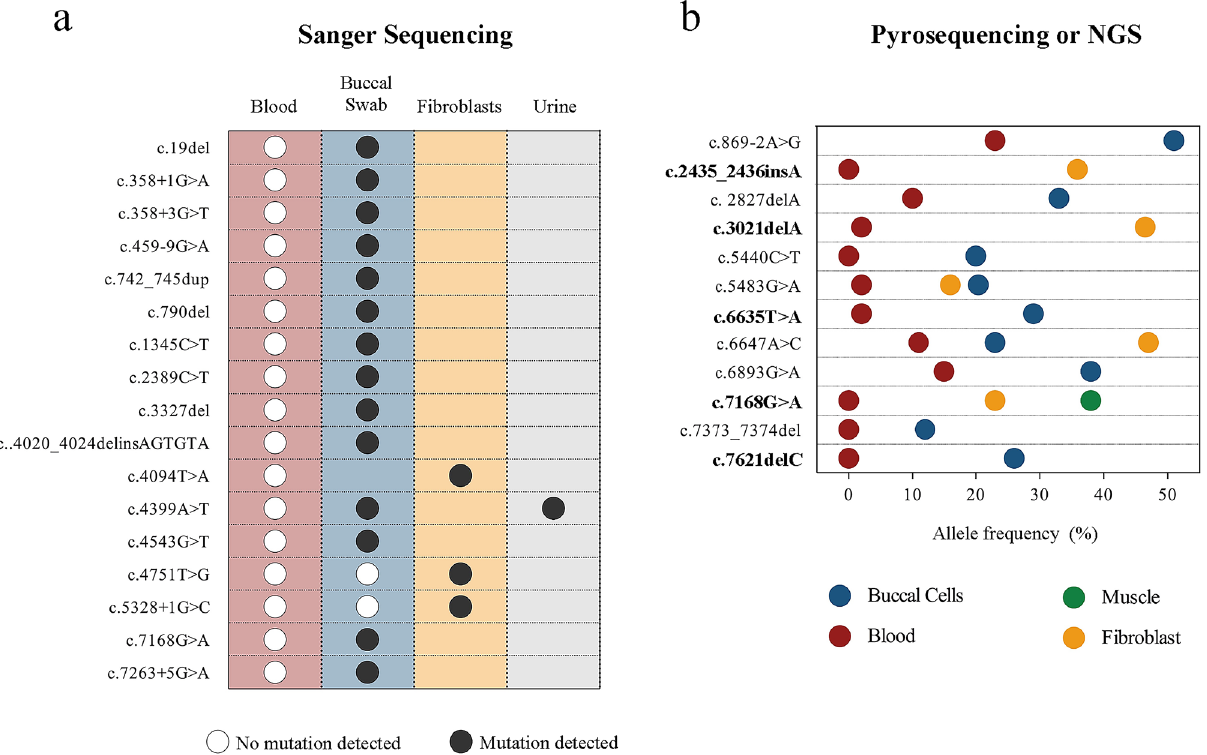
Figure 2. Summary of PZM sequencing results in different tissues: Picture illustrate individuals with at least two tissues analyzed. ( a ) Sanger sequencing results in 17 published patients with PZM variants in NIPBL . Dots indicate genetic variant detected (black) or not detected (white) in the different tissues analyzed. ( b ) The graph shows the alternative allele frequency of the PZM variants calculated by NGS or pyrosequencing in 12 patients (7 already published and 5 novel patients). Each line corresponds to a patient, colored dots indicate the tissue sample analyzed: blood (red), buccal swab (blue), fibroblasts (yellow) or skeletal muscle